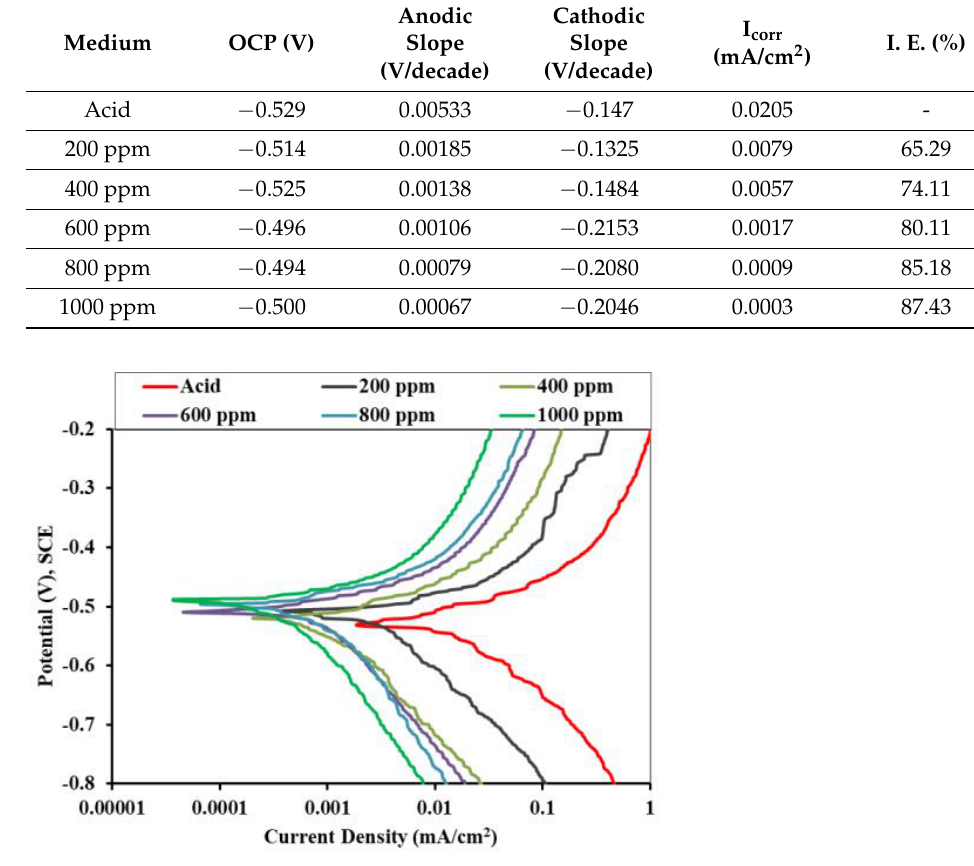
concentrations of inhibitor immersed condition.